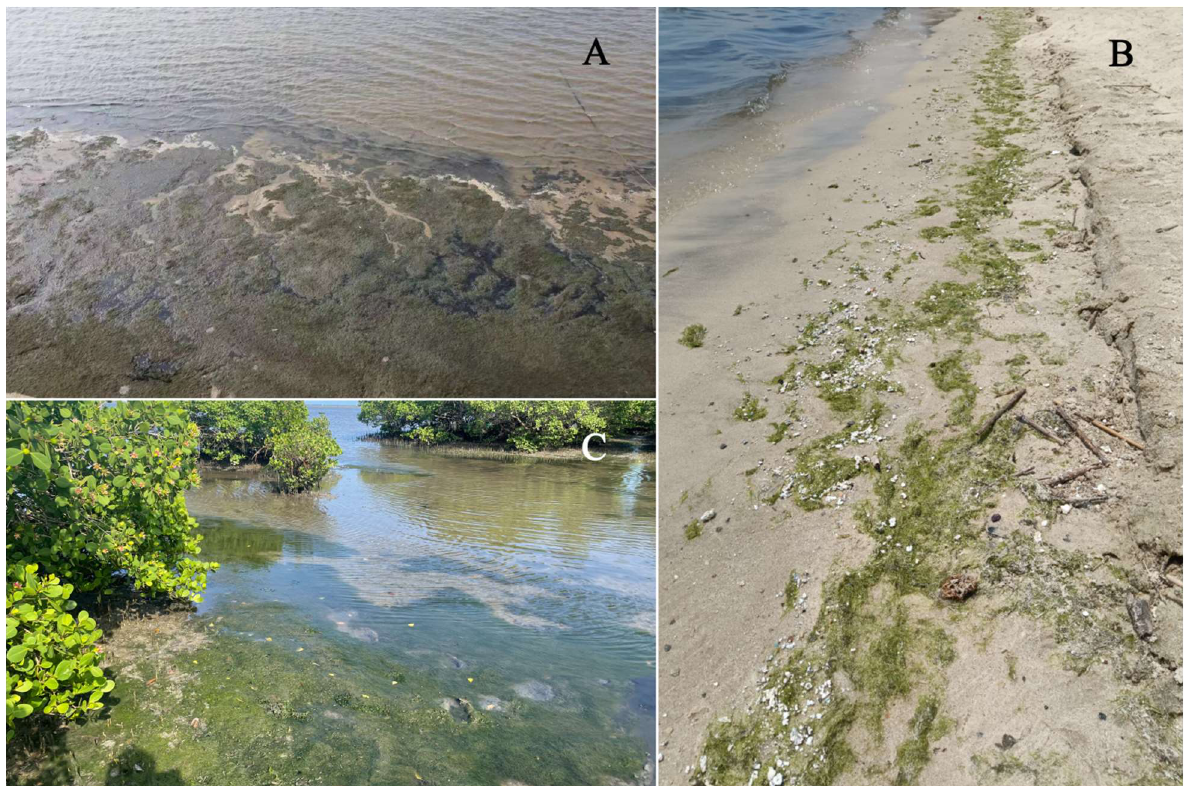
Figure 1. Green tide outbreaks dominated by U. meridionalis in ( A ) Yingkou, Dalian City, Liaoning Province, August 2021; ( B ) Qidong, Nantong City, Jiangsu Province, July 2021; ( C ) Wenchang City, Hainan Province, May 2021.